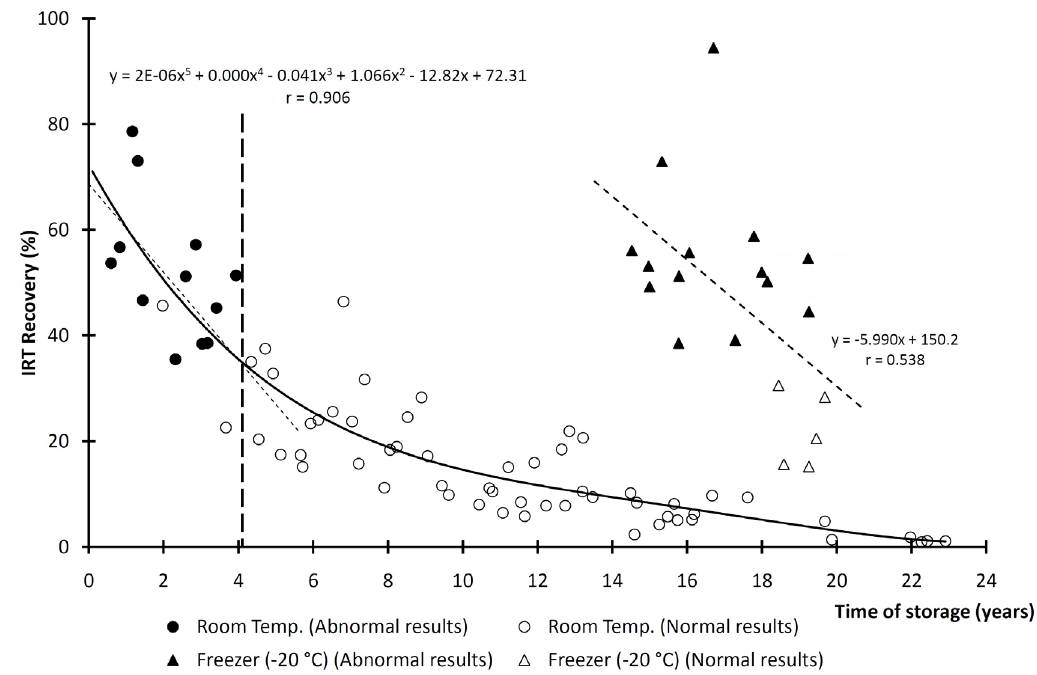
Figure 4. IRT recovery at retesting in residual DBS specimens stored in two different storage conditions. Note: the legend Abnormal/Normal results indicate the qualitative results interpretation at